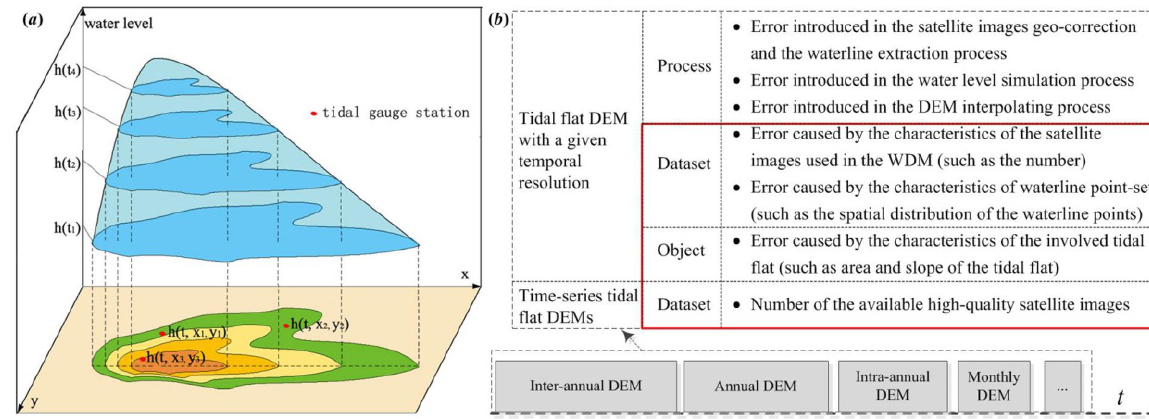
Figure 2. ( a ) Diagram illustrating the waterline method; ( b ) potential errors in the waterline method. DEM, digital elevation